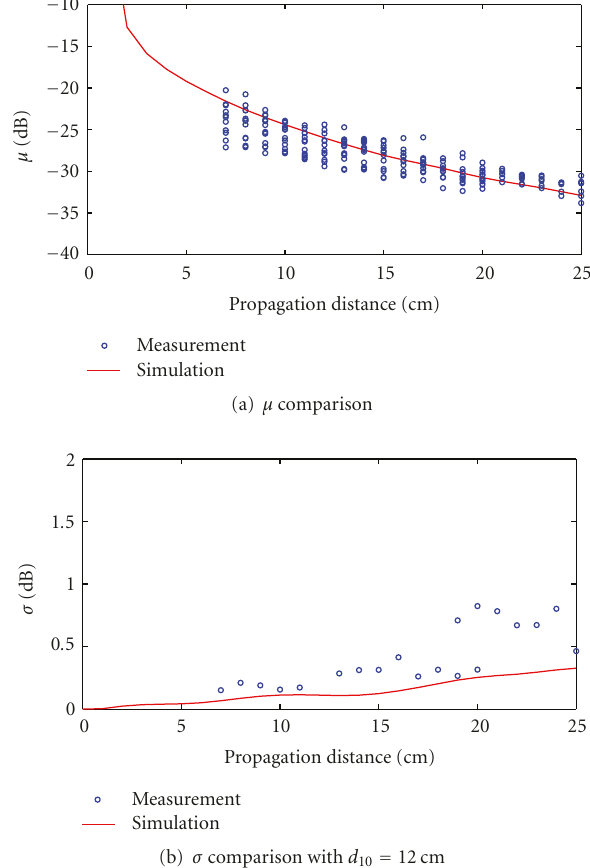
Figure 13: Comparisons of the mean ( μ ) and std ( σ ) of the channel fading amplitude (dB) for on-body channels along the trunk (vertical direction) in normal